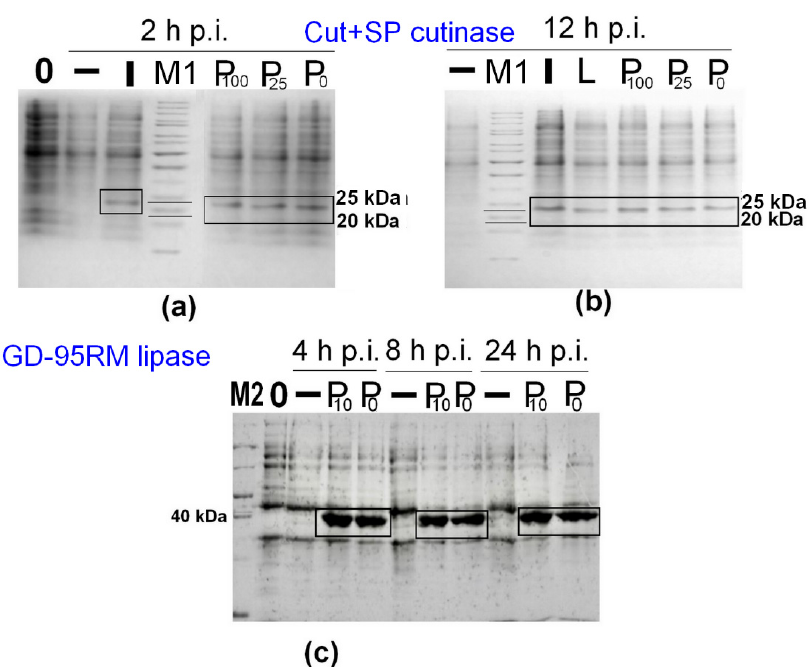
Figure 3. Influence of ampicillin concentration in the cultivation medium for recombinant Cut+SP ( a , b ) and GD-95RM enzymes ( c ) synthesis. M1—PageRuler™ Unstained Protein Ladder; M2—PageRuler™ Unstained Broad Range Protein Ladder; P—for induction MP (4 mM) was used as an inducer; 100, 25, 10, 0—mark a concentration of ampicillin ( µ g/ mL) added to the medium; I—for induction IPTG (1 mM) as an inducer was used as an inducer; L—for induction lactose (4 mM) as an inducer was used as an inducer; —–control sample of recombinant E. coli BL21 (DE3) cells growing without induction; p.i.—post-induction time in hours. The target enzymes are marked with